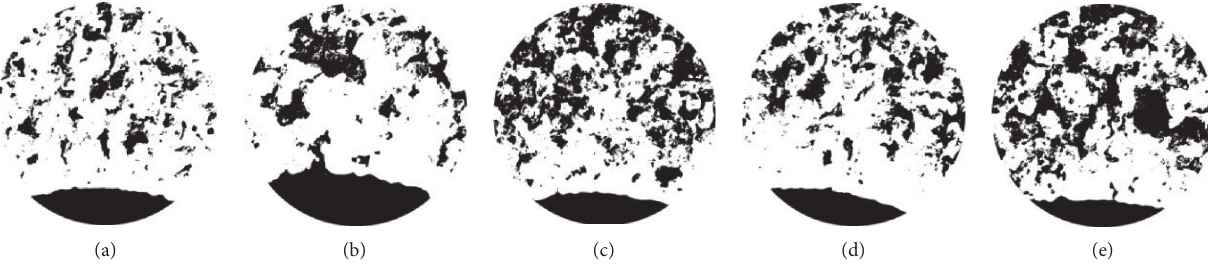
Figure 8: Microporosity change diagram of B zone in yellow sandstone under freeze-thaw cycles. (a) Freeze-thaw 0 times. (b) Freeze-thaw 5 times. (c) Freeze-thaw 10 times. (d) Freeze-thaw 20 times. (e) Freeze-thaw 40